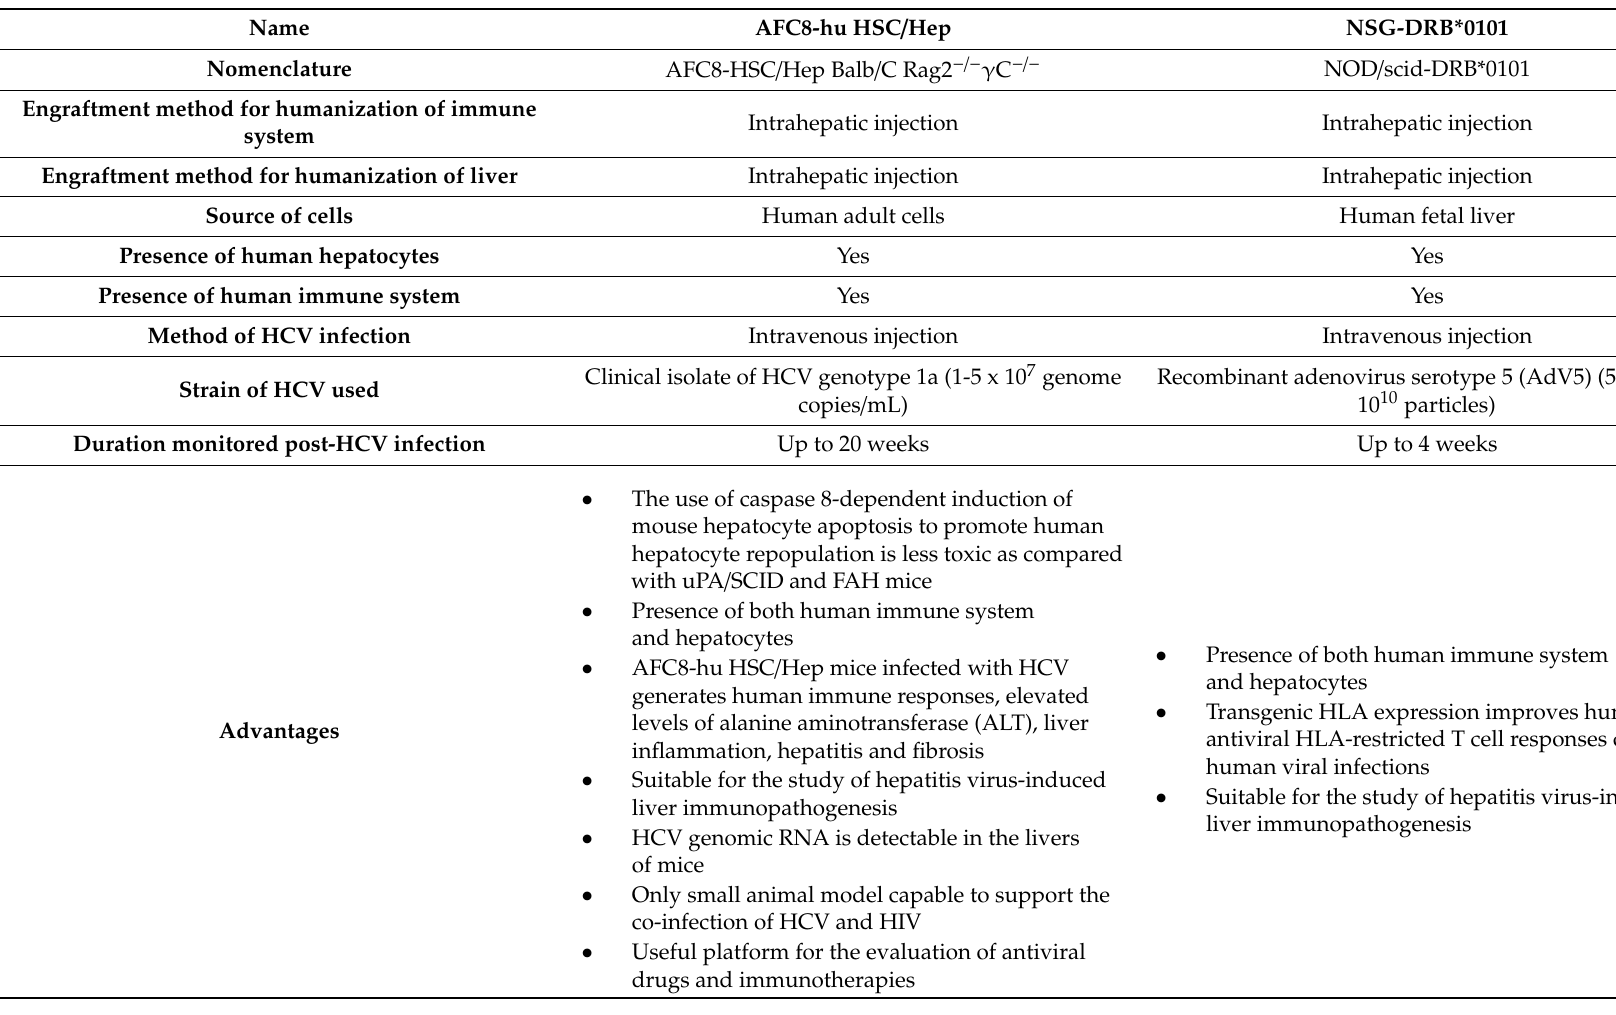
Table 3. Humanized mouse models with both human immune system and